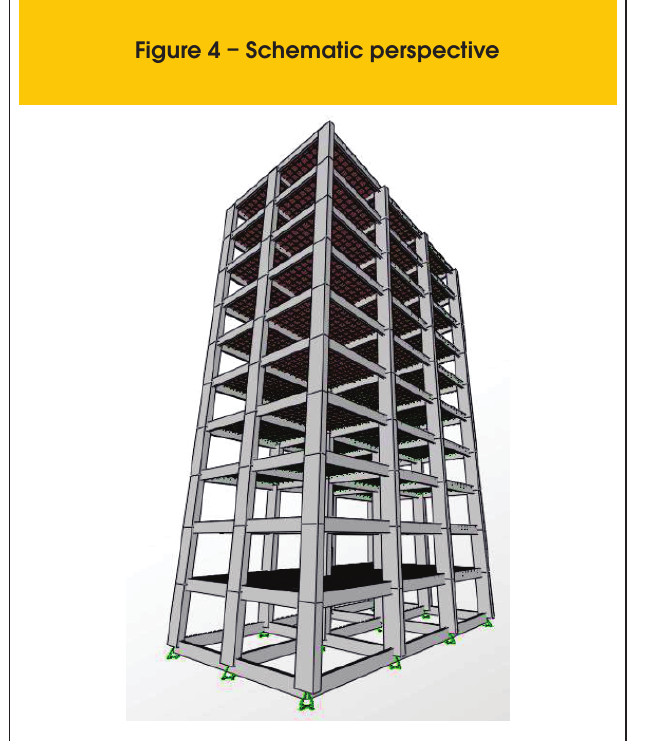
Figure 5 – Elastic response spectra according the several